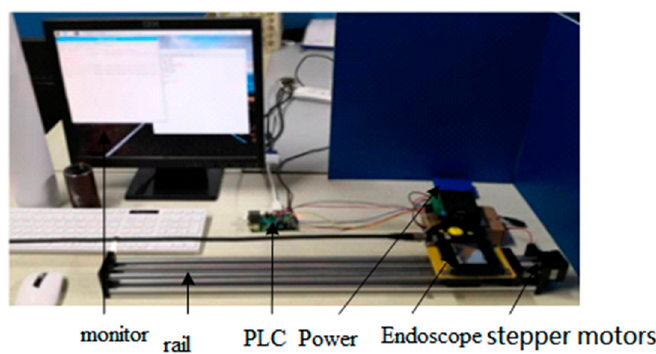
Figure 3. Endoscopic acquisition platform.